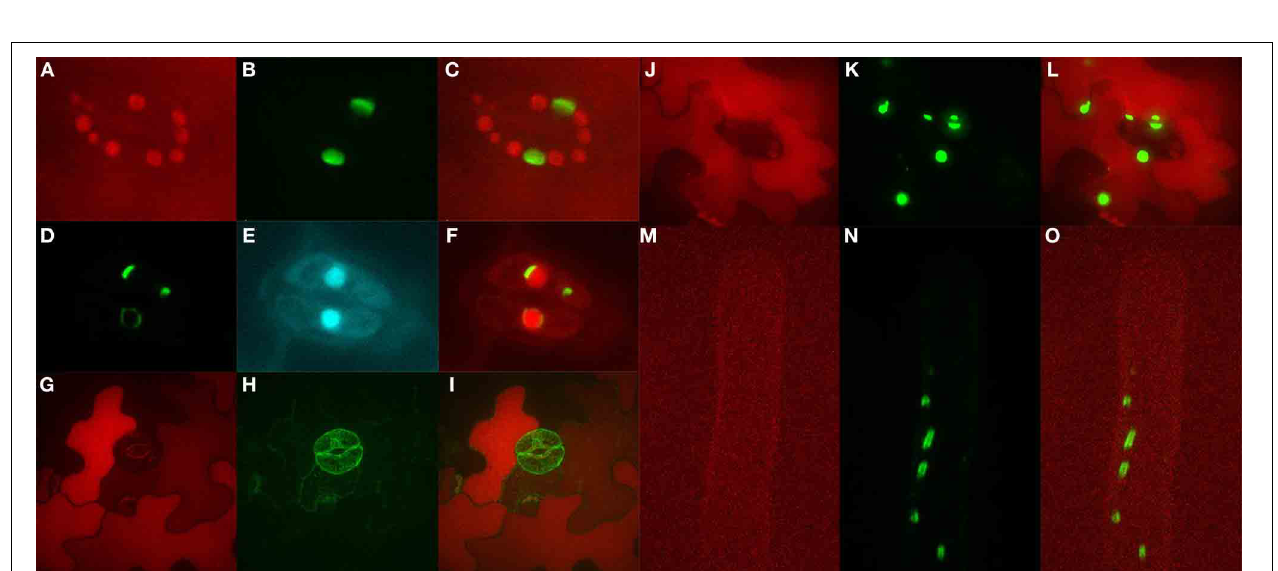
AtYSL4-GFPmid and γ -TIP-mCherry . Middle row: protoplast co-transformed with AtYSL6-GFPmid and γ -TIP-mCherry . Bottom row: protoplast transformed with AtYSL6-GFPmid and stained with the membrane-selective dye FM-464. Scale bar = 10 um.